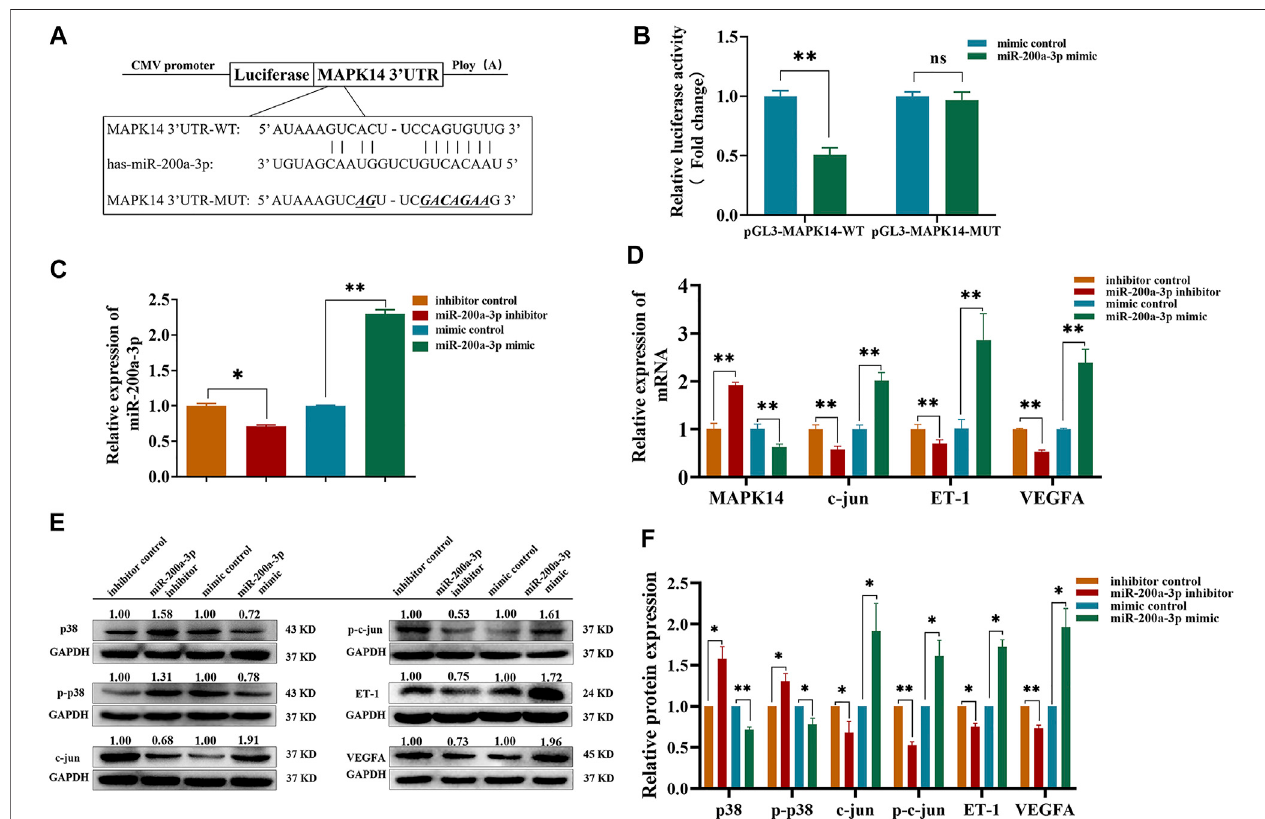
FIGURE 5 | miR-200a-3p directly targets the 3 ′ UTR of MAPK14 and regulates the expression levels of p38, c-jun, ET-1 and VEGFA. (A) The MAPK14 3 ′ -UTR containingthewildtype ormutantmiR-200a-3p bindingsequence wasinsertedintodownstreamoftheluciferasereportervector. Themutatedsequencesareitalicized. (B) The dual luciferase reporter assay revealed that the luciferase activity controlled by MAPK14 3 ′ -UTR was inhibited byectopic miR-200a-3p expression in 293Tcells. (C) miR-200a-3p was highly expressed or knocked down in HUVEC by lipofectamine 2000 transfection. QRT-PCR analysis was performed to measure the expression levels of miR-200a-3p in HUVEC after treatment with miR-200a-3p mimic, mimic control or miR-200a-3p inhibitor, inhibitor control. (D) The mRNA levels of MAPK14, c-jun, ET-1 and VEGFA were determined by qRT-PCR in HUVEC transfected with miR-200a-3p mimic, mimic control or miR-200a-3p inhibitor, inhibitor control. (E) Western blot analysis of p38, phosphorylated p38, c-jun, phosphorylated c-Jun, ET-1 and VEGFA protein levels in HUVEC transfected with miR-200a-3p mimic, mimic control or miR-200a-3p inhibitor, inhibitor control. (F) Quanti fi cation of protein results in panel E. Data were expressed as mean ± SEM. Between group differences were assessed by the student ’ s t test, respectively. * p < 0.05, ** p < 0.01, ns, not signi fi